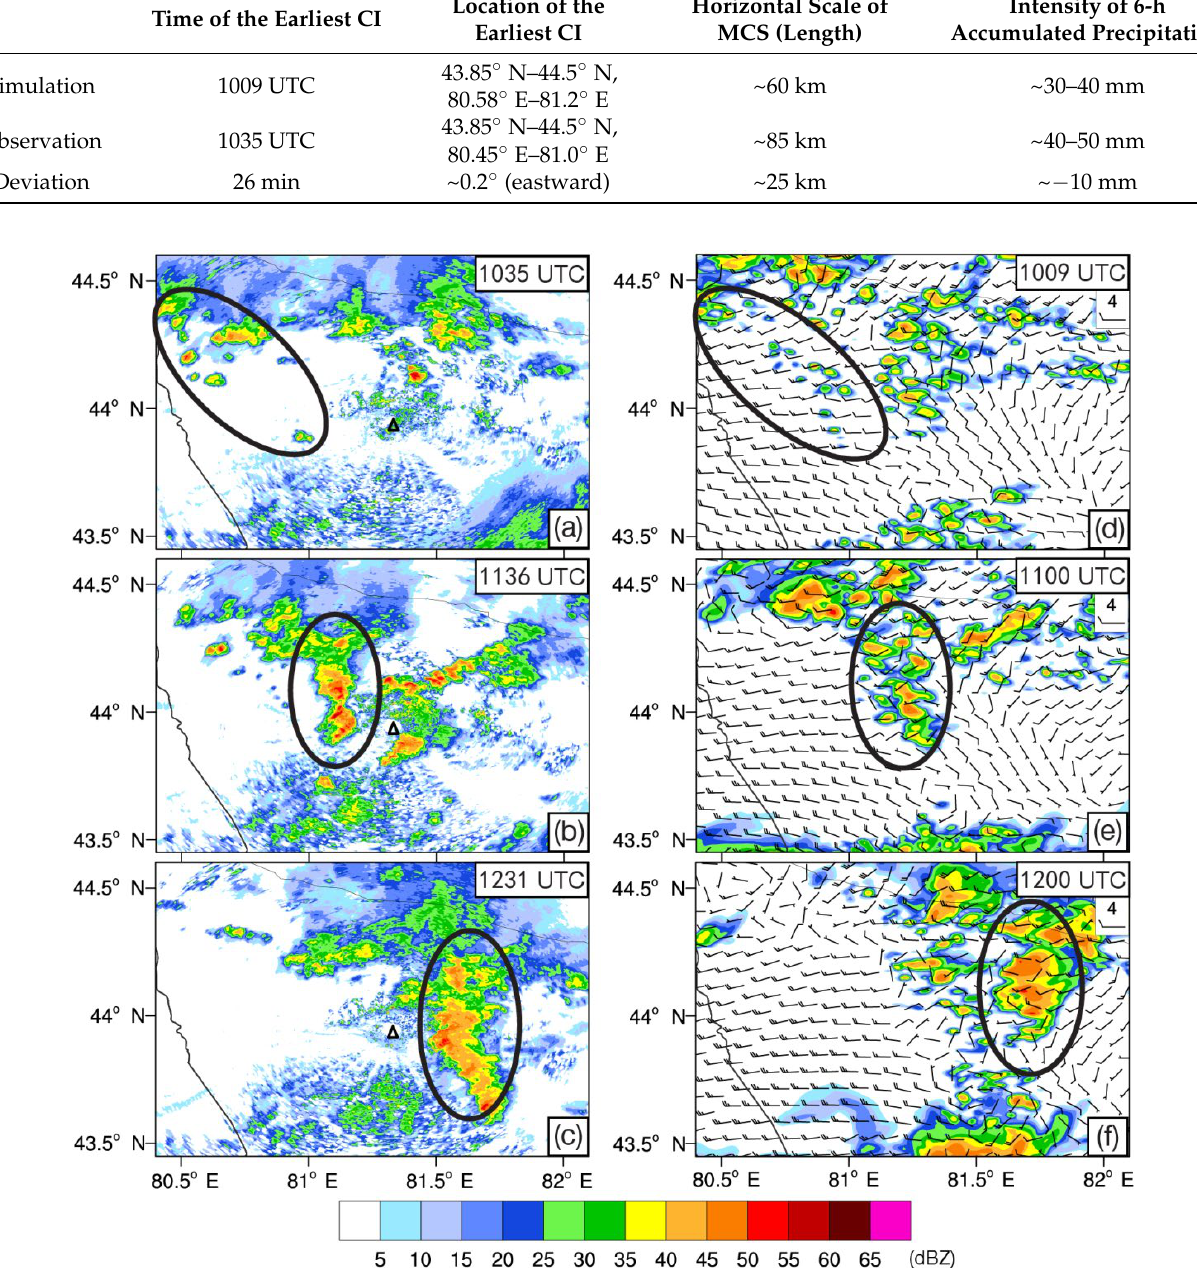
Figure 7. ( a – c ) Composite radar reflectivity (left panels, shading, units: dBZ) observed at Yining radar station (indicated by black triangle) on 17 June 2016. ( d – f ) Simulated composite reflectivity (shading, units: dBZ) and wind field (full and half barbs represent 4 and 2 m s − 1 , respectively) at 10 m height above the ground level on 17 June 2016. The specific time is shown in the upper right corner of each panel. The major convection initiation and intensification areas are indicated by black